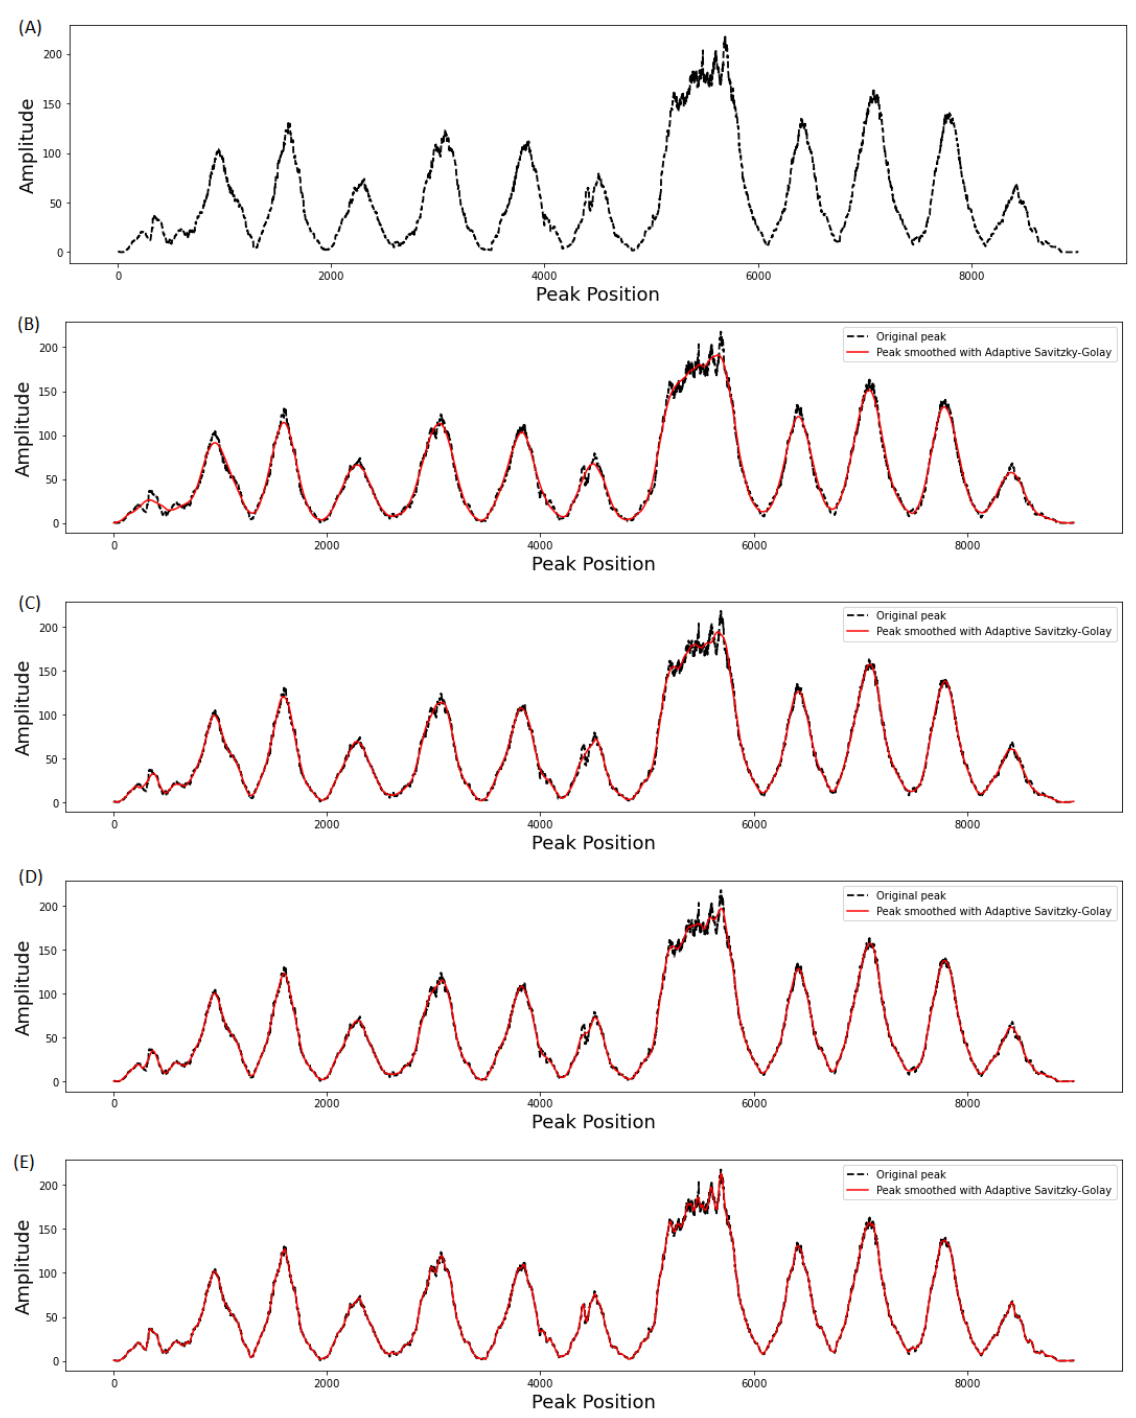
Figure 2. Smoothing performance of Adaptive Savitzky–Golay. ( A ): Original peak corrupted with noise; ( B ): SG filter k 1 = 2, m 1 = 253. ( C ): SG filter k 2 = 3, m 2 = 201; ( D ): SG filter k 3 = 4, m 3 = 153. ( E ): SG filter k 4 = 5, m 4 = 51. The dotted black line is the original peak and solid red line is the smoothed